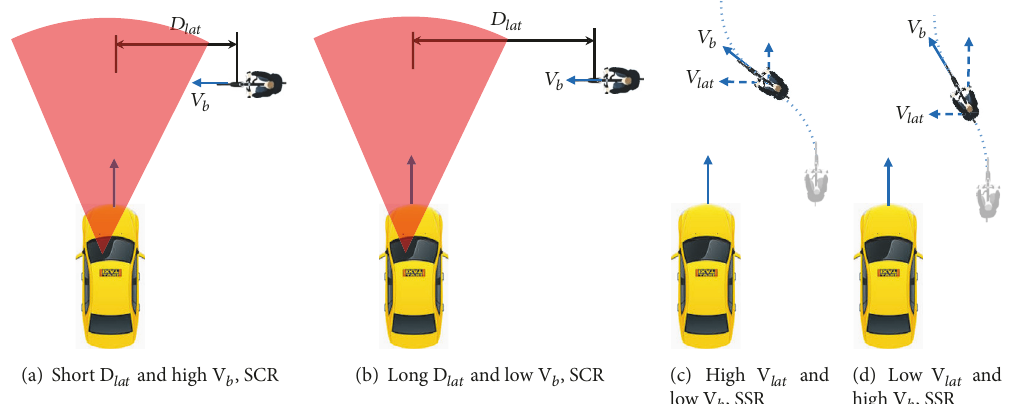
Figure 14: The influence of V 𝑏 and D 𝑙𝑎𝑡 or V 𝑙𝑎𝑡 on ET.